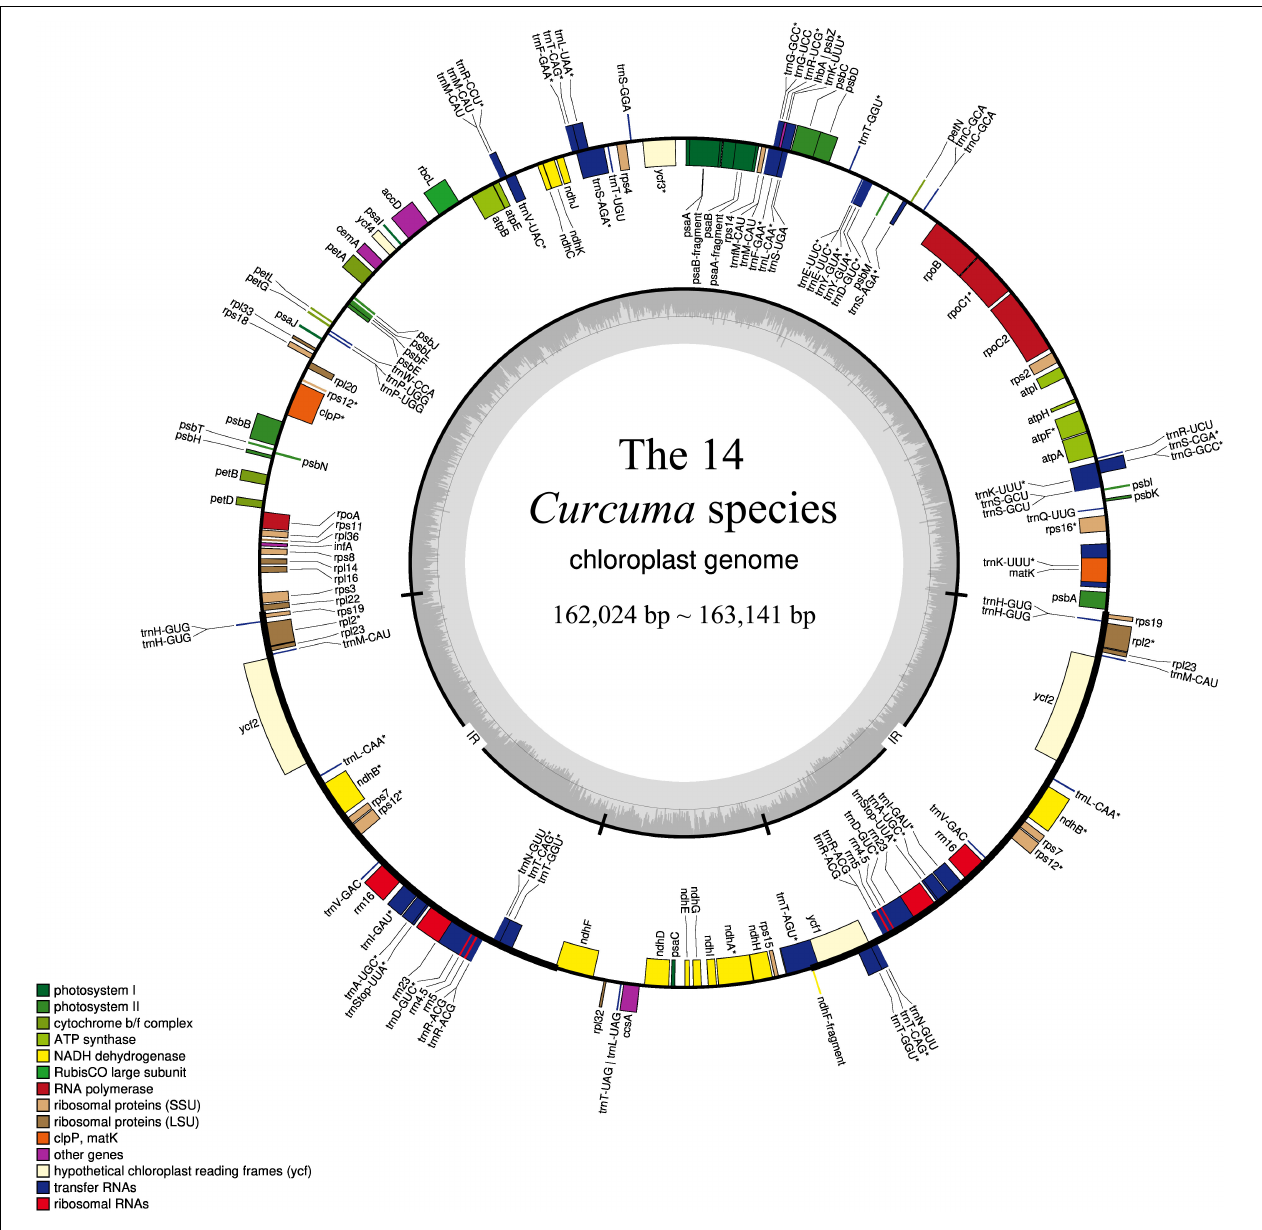
FIGURE 1 | Gene structural map of the 14 Curcuma chloroplast genome. Genes of different functional groups, Small single copy (SSC), Large single copy (LSC), and Inverted repeats (IRa, IRb), are separated by color. Genes drawn inside the circle are transcribed